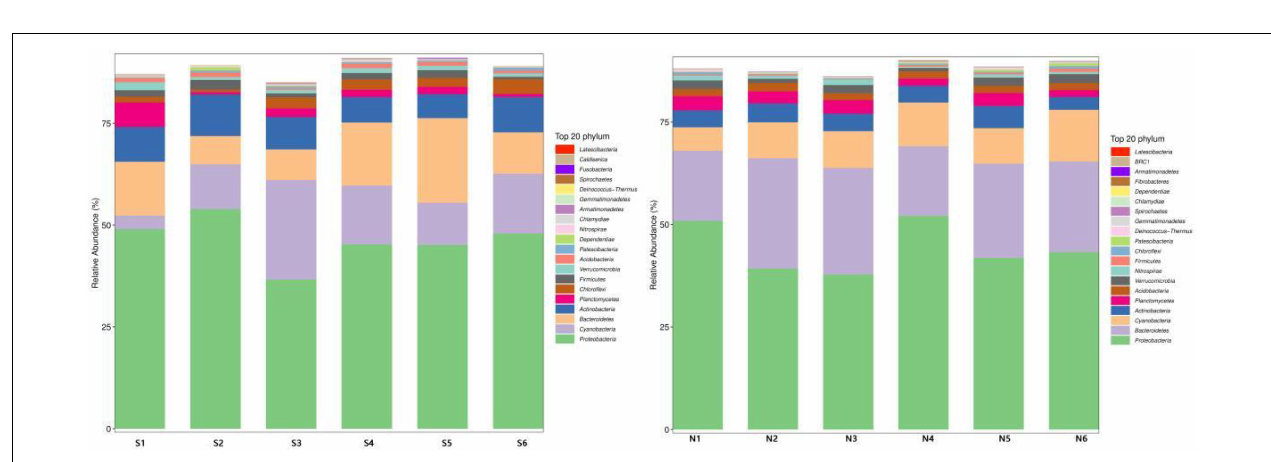
FIGURE 4 | Nutrient concentrations in sediment of South (A) and North (B) Taihu Lake.